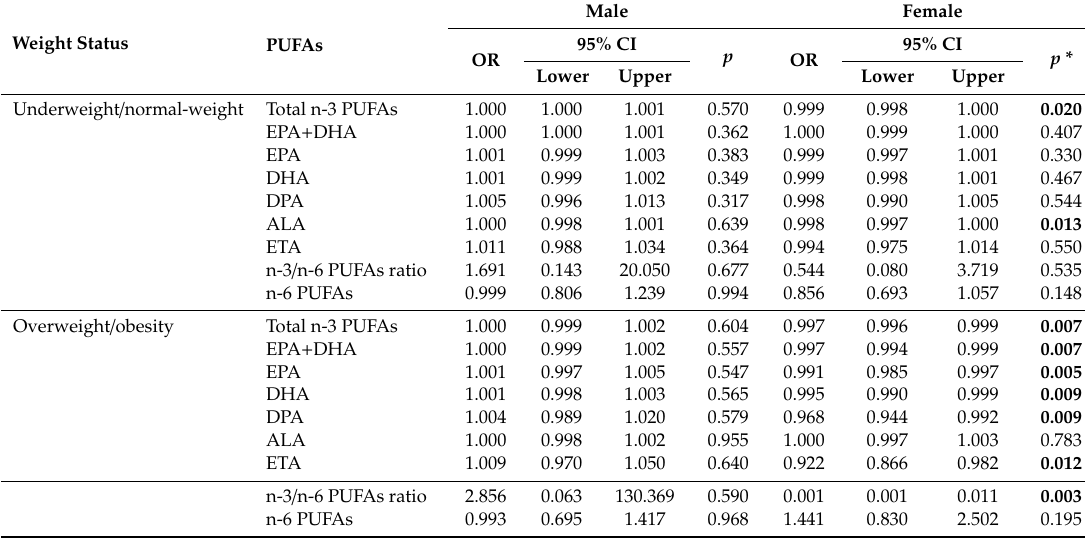
Table 5. Relationship between n-3 PUFAs intake and depressive states by sex and weight status (logistic regression